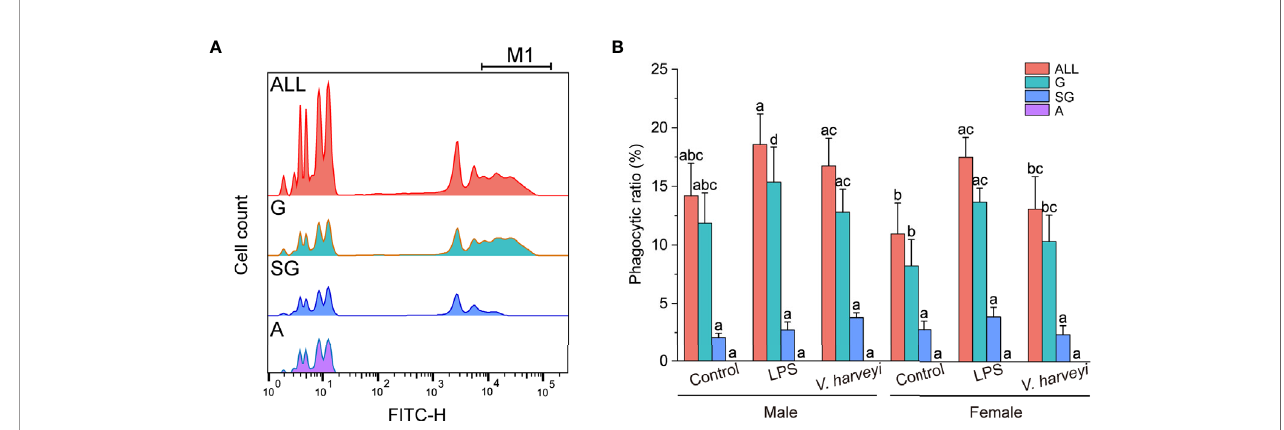
FIGURE 5 | Phagocytic capability of each hemocyte subpopulation. (A) Histogram of fl uorescence representing phagocytic activity recorded in different hemocyte subpopulations: M1, hemocytes that engulfed three or more fl uorospheres. (B) Phagocytic ratios of different subpopulations after stimulation. The means denoted by different letters for each fi xed hemocyte subpopulation are signi fi cantly different among the different stimulation types ( p < 0.05). G, granulocytes; SG, semi- granulocytes; A,